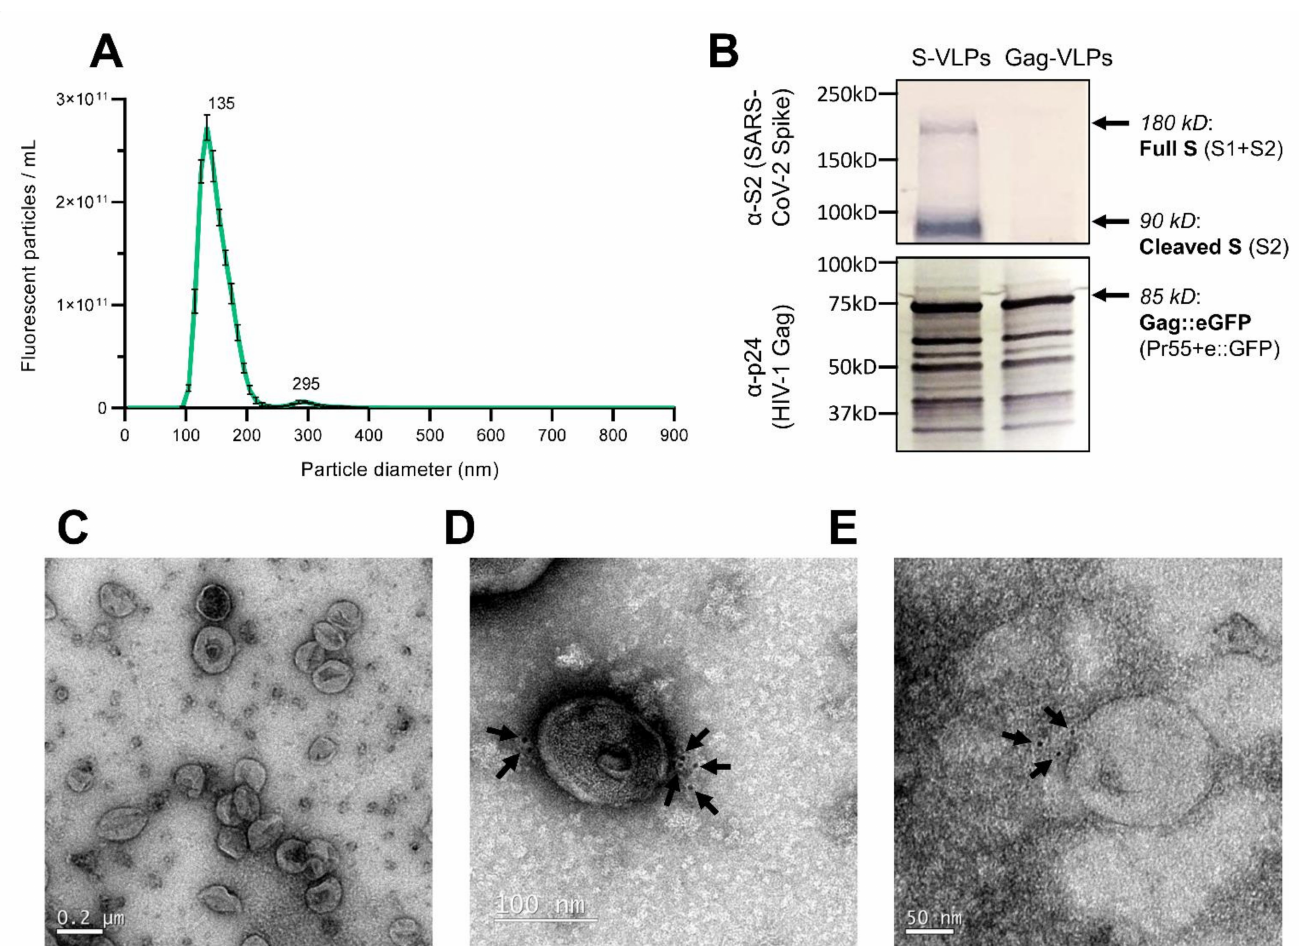
Figure 2. Characterization of the produced S-VLPs. ( A ): Particle-size distribution of the purified S-VLPs, analyzed by NTA. ( B ): Western blot of purified S-VLPs and G-VLPs. Top: Membrane was treated with an anti-SARS-CoV-2 S2 spike subunit polyclonal antibody, followed by a goat anti-rabbit secondary incubation. Bottom: Membrane was treated with an anti-HIV-1 p24 monoclonal antibody, followed by goat anti-mouse secondary incubation. Both S-VLPs and G-VLPs showed HIV-1 Gag bands by Western blot, while only S-VLPs showed intense SARS-CoV-2 protein bands. ( C–E ): Electron microscopy images of the purified VLPs. ( C ): CryoTEM of untreated purified S-VLPs. ( D ): Gold- immunolabeled TEM. ( E ): Gold-immunolabeled CryoTEM. Grids were treated with an anti-S protein monoclonal antibody, followed by incubation with goat anti-human secondary coupled with 6 nm gold particles. Gold-immunolabeled S-VLPs showed S protein localization (arrows) on the surface of the chimeric